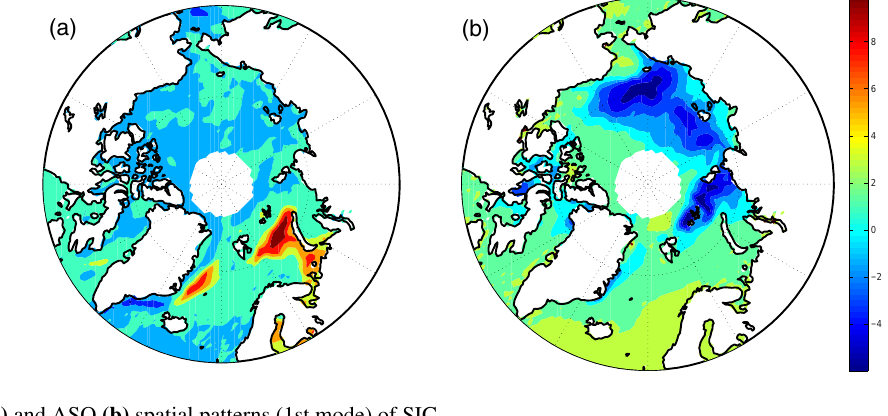
Figure 1. FMA (a) and ASO (b) spatial patterns (1st mode) of SIC.